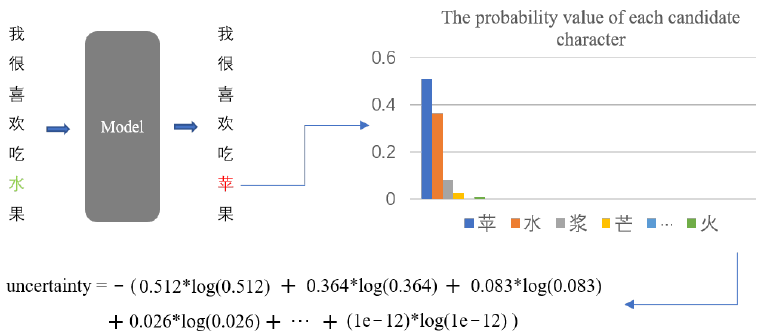
Figure 4. Our method calculates the character ( 水 ) position’s error uncertainty (uncertainty) in the original sentence.